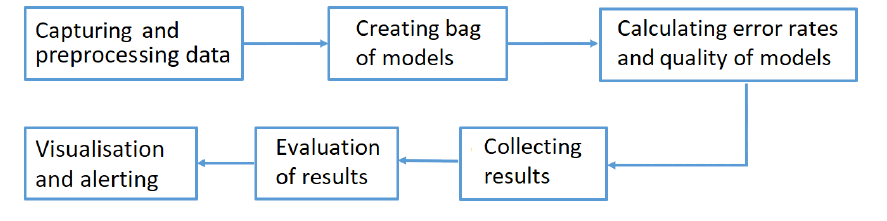
Figure 5. Algorithm flow